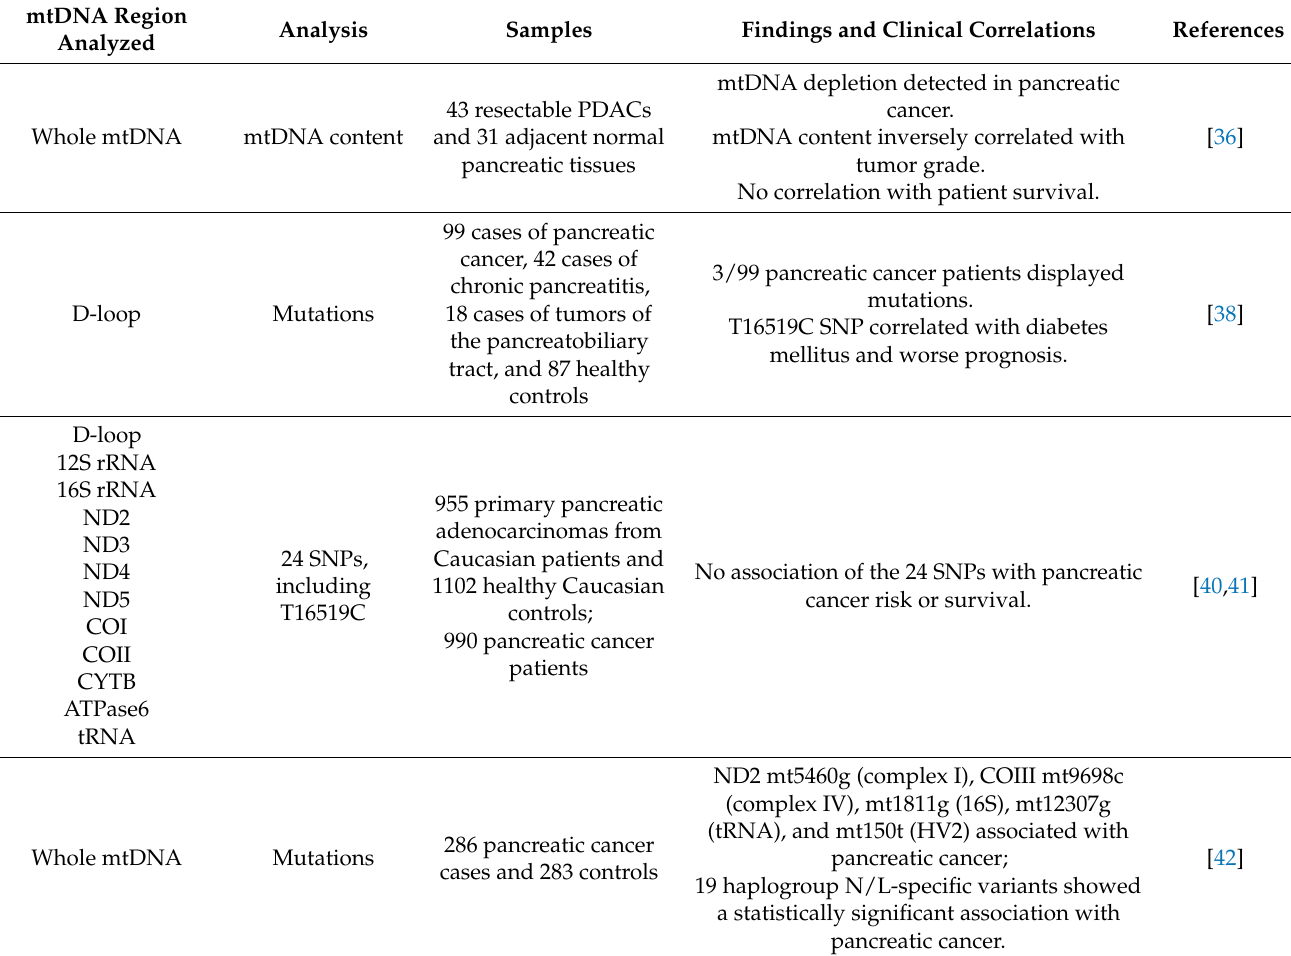
Table 1. mtDNA changes in pancreatic cancer and clinical